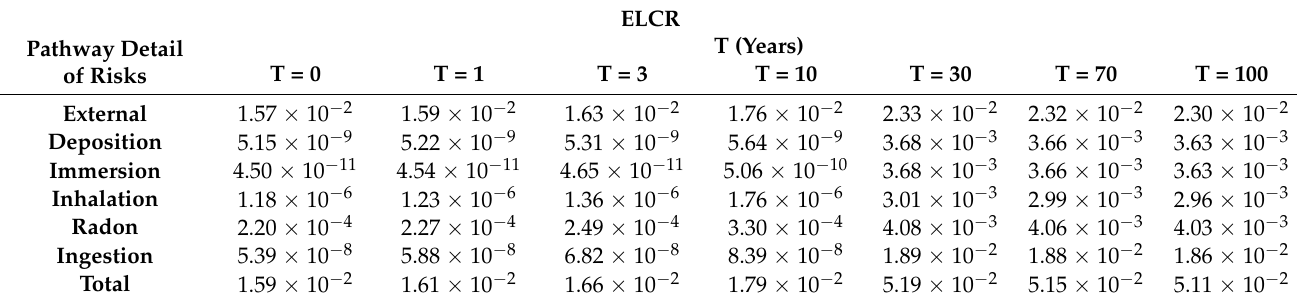
Table 7. Total risk of excess cancer for all exposure